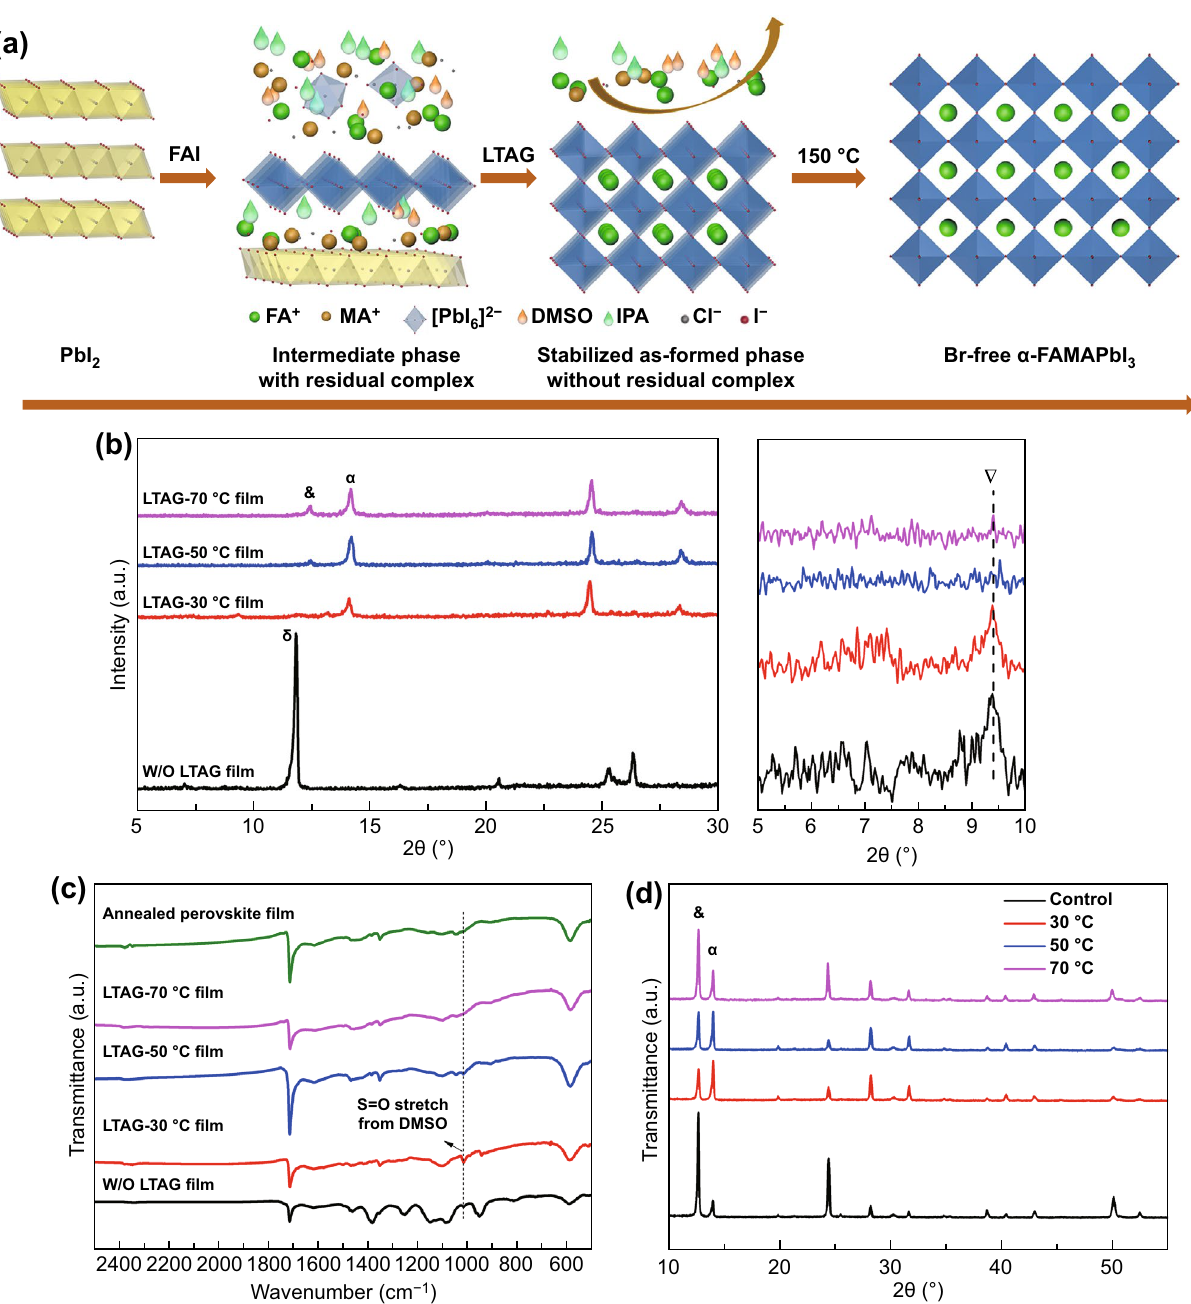
Fig. 1 a Schematic representation of the film crystallization process of an LTAG‑based FAMAPbI 3 perovskite layer. b XRD patterns of the as‑ formed films obtained using the control process and the LTAG method. &, α , δ , ∇ Mean characteristic diffraction signals of the PbI 2 , black per‑ ovskite, yellow perovskite phases, and intermediate phase, respectively. c FTIR spectrum of the as‑formed film powers using the control process and the LTAG method and for postannealed FAMAPbI 3 film. d XRD patterns of annealed perovskite layers prepared without (control) and with LTAG treatment (at 30, 50, and 70